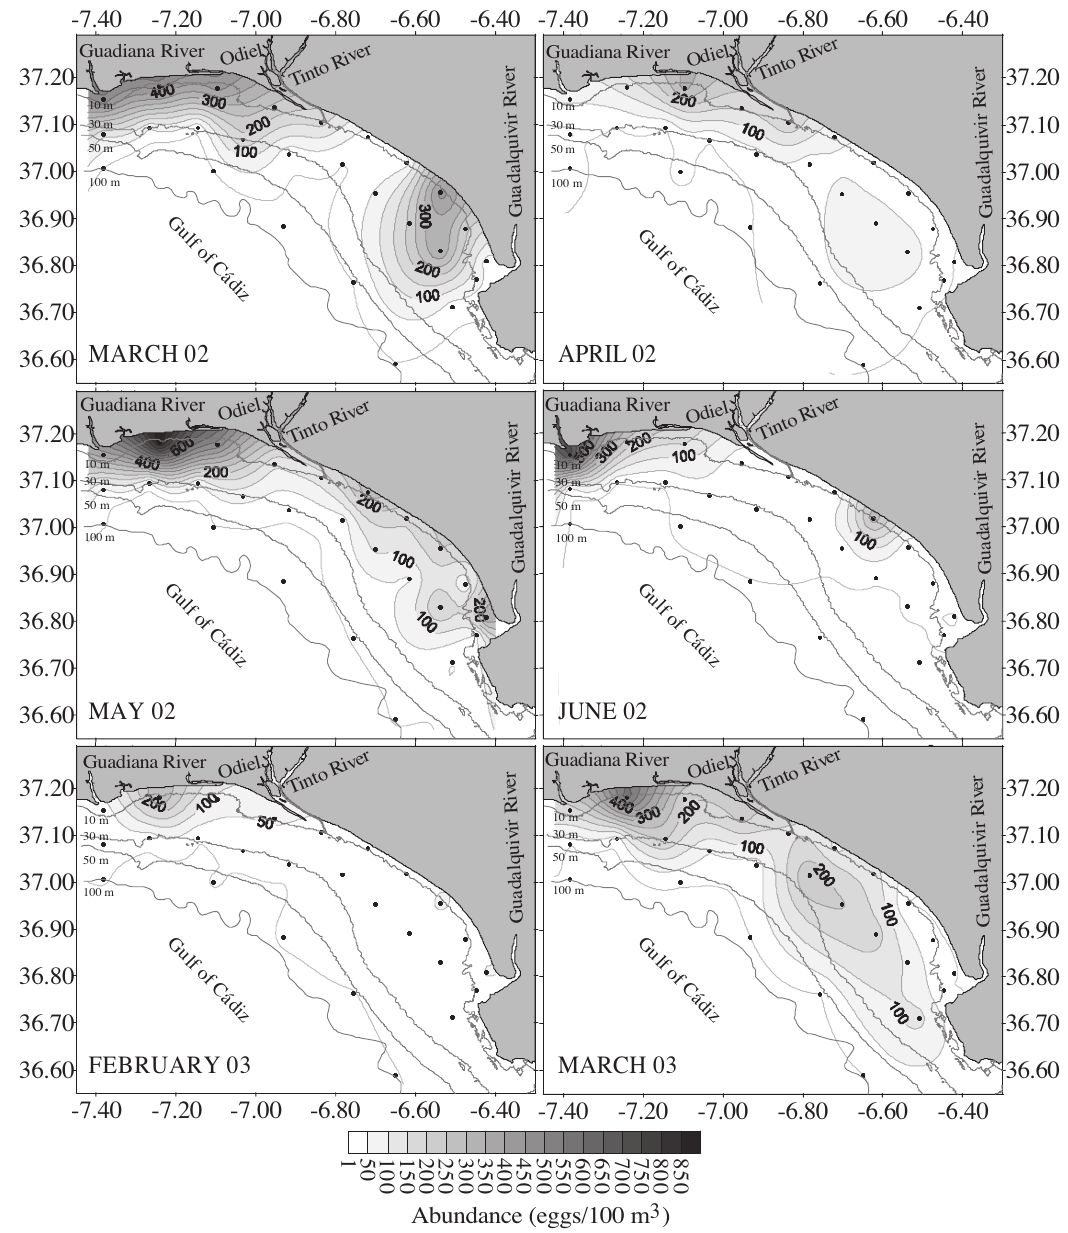
F IG . 2. – Horizontal distribution of the abundance of wedge sole eggs (number/100 m 3 ) during the main reproduction